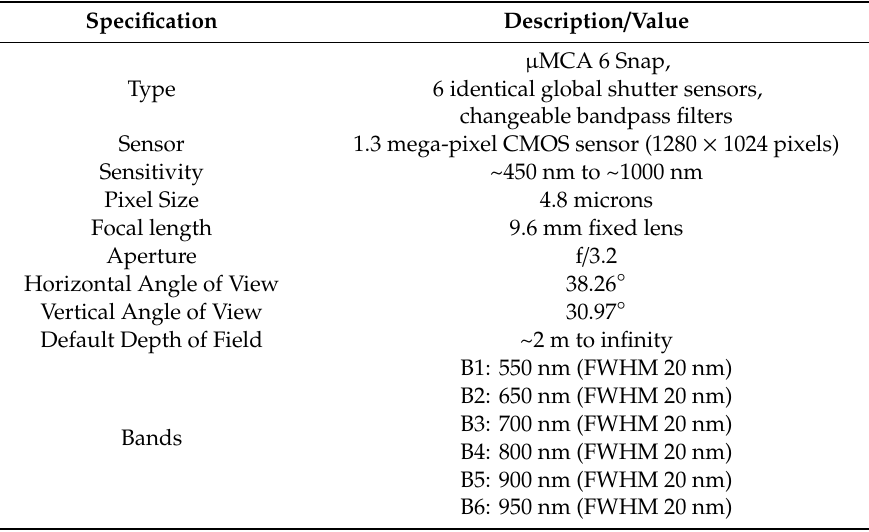
Figure 1. Multispectral 6-channel camera Tetracam uMCA Snap 6 equipped with 6 1.3 mega-pixel complementary metal oxide semiconductor (CMOS) sensors and changeable bandpass filters. This filter set includes 550 nm, 650 nm, 700 nm, 800 nm, 850 nm, 900 nm filter with FWHM 20 mm. Table 1. The parameters of Tetracam μ -MCA Snap 6 camera.